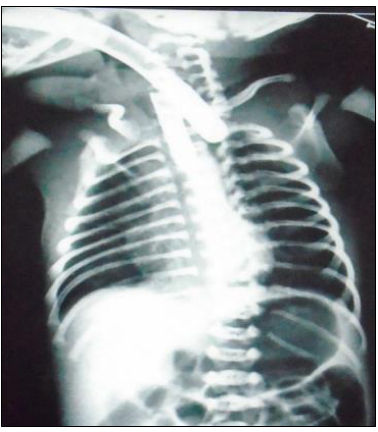
Figure 1: The radiograph revealed red rubber catheter in upper pouch and a cylindrical foreign body in the upper aero-digestive